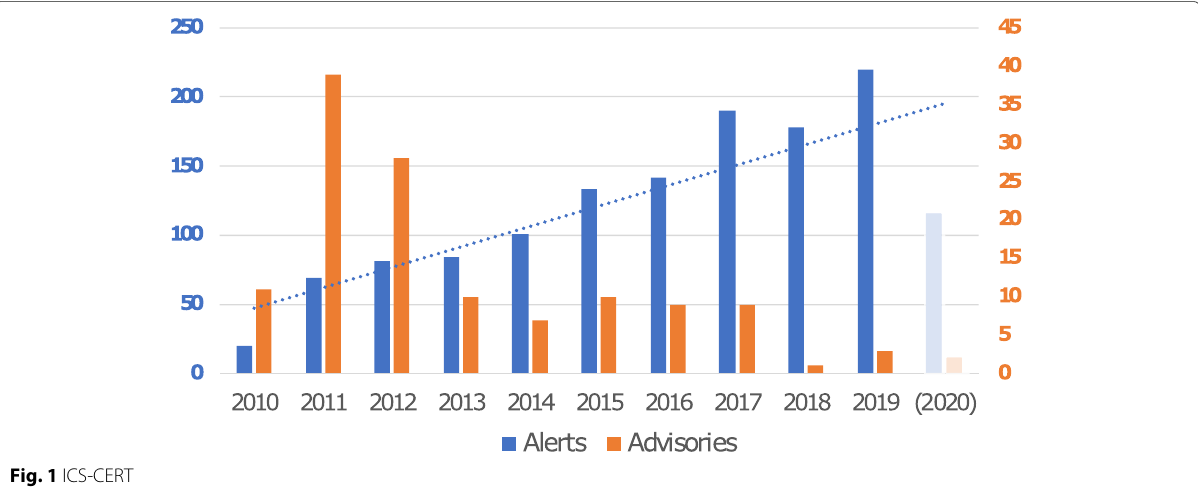
Over the last decade, the number of security advisories issued per year has been steadily growing. Before 2014 less than 100 advisories per year have been issued, while from 2017 to 2019 more than 200 advisories per year have been issued. These numbers of security advisories correlate well with the observed increase in the